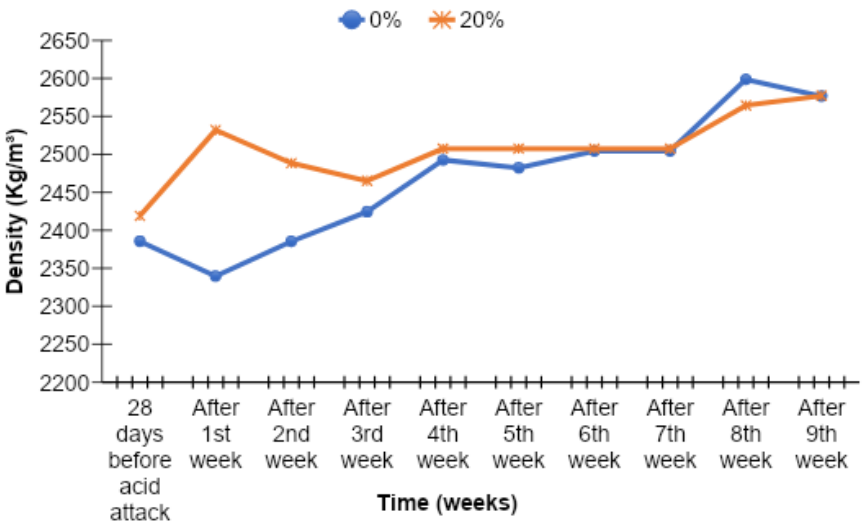
Figure 21. Comparison of density versus time curves for 0% (control) and 15% MK contents.